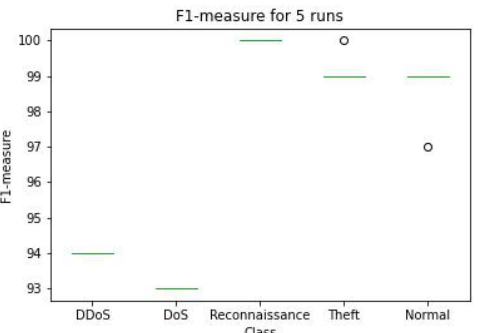
Figure 8. F1 measure after running the five different experiment with different